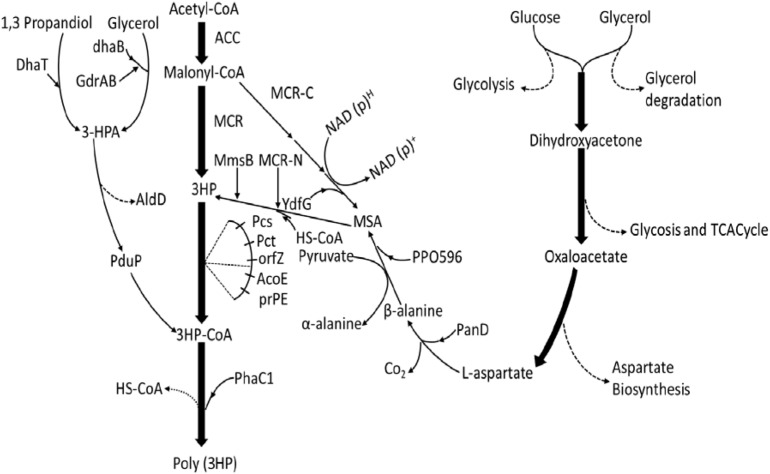
Overview of the four biosynthetic poly(3HP) production pathways from different engineered strains with different starting substrates. From 1, PduP route (– – – (DhaB and GdrAB, glycerol dehydratase; PduP, PhaC1.3-HP route (—–): poly(3HP) synthesis from glycerol and 1, 3-propanediol. DhaB and GdrAB, glycerol dehydratase; Dhat, AldD, Pcs’ (ACS), Pct, PhaC1. Malonyl-CoA route (– – –): poly(3HP) synthesis from Acetyl-CoA, Acc, MCR, PrpE, Pcs’, PhaC1. β-alanine route (– – –): poly(3HP) synthesis from glucose and glycerol. Aspartate biosynthesis, PanD, PP0596, YdfG, PrpE, PhaC1 (Steinbüchel and Lütke-Eversloh, 2003; Andreeßen et al., 2010, 2014b; Wang et al., 2012, 2013; Feng et al., 2015; Lacmata et al., 2017).